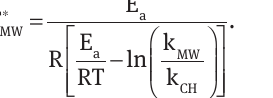
Figure 5: The dependence of the E MWHCC (■).